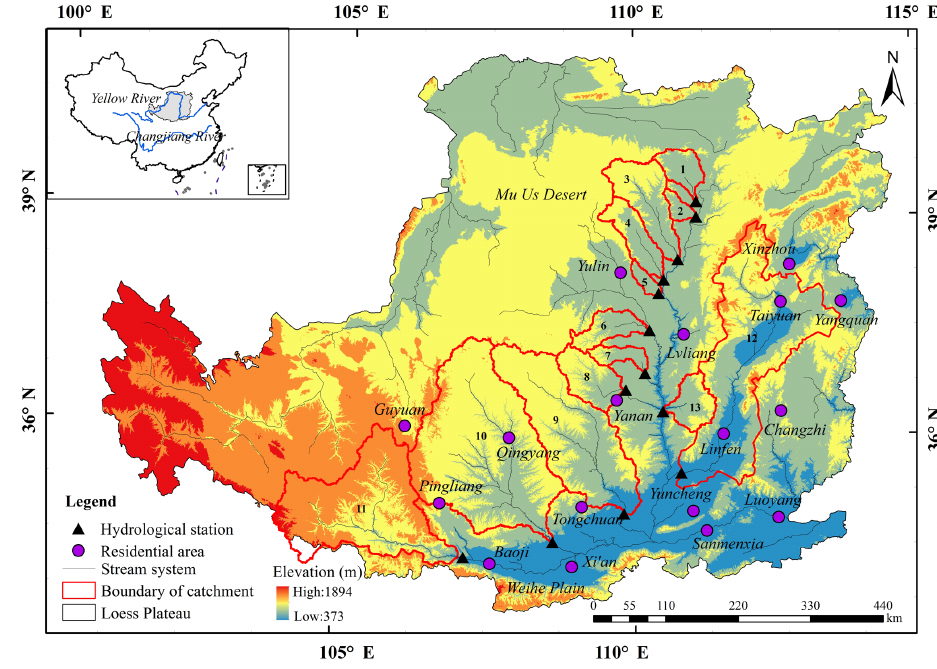
Figure 1. Map of the study area. Table 1. Watershed characteristics and hydrological data for the study period